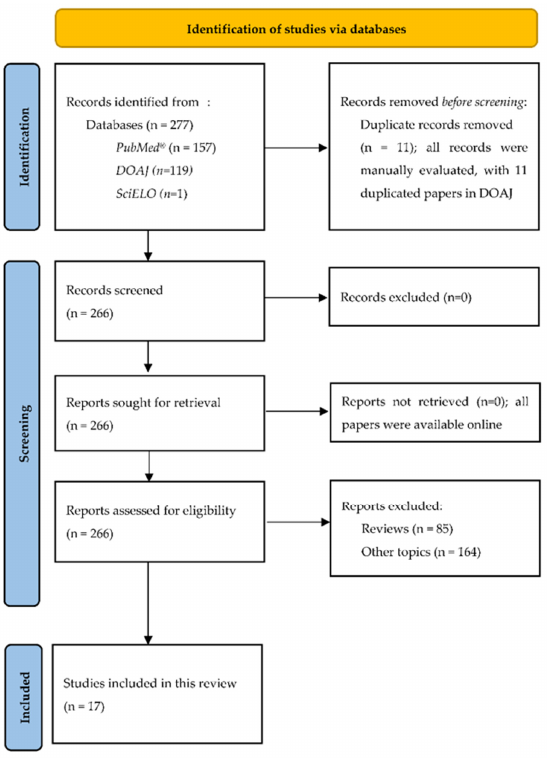
Figure 1. The Systematic Reviews and Meta-Analyses (PRISMA) flow diagram: selection of studies on the identification of repurposing drugs against COVID-2019 through AI